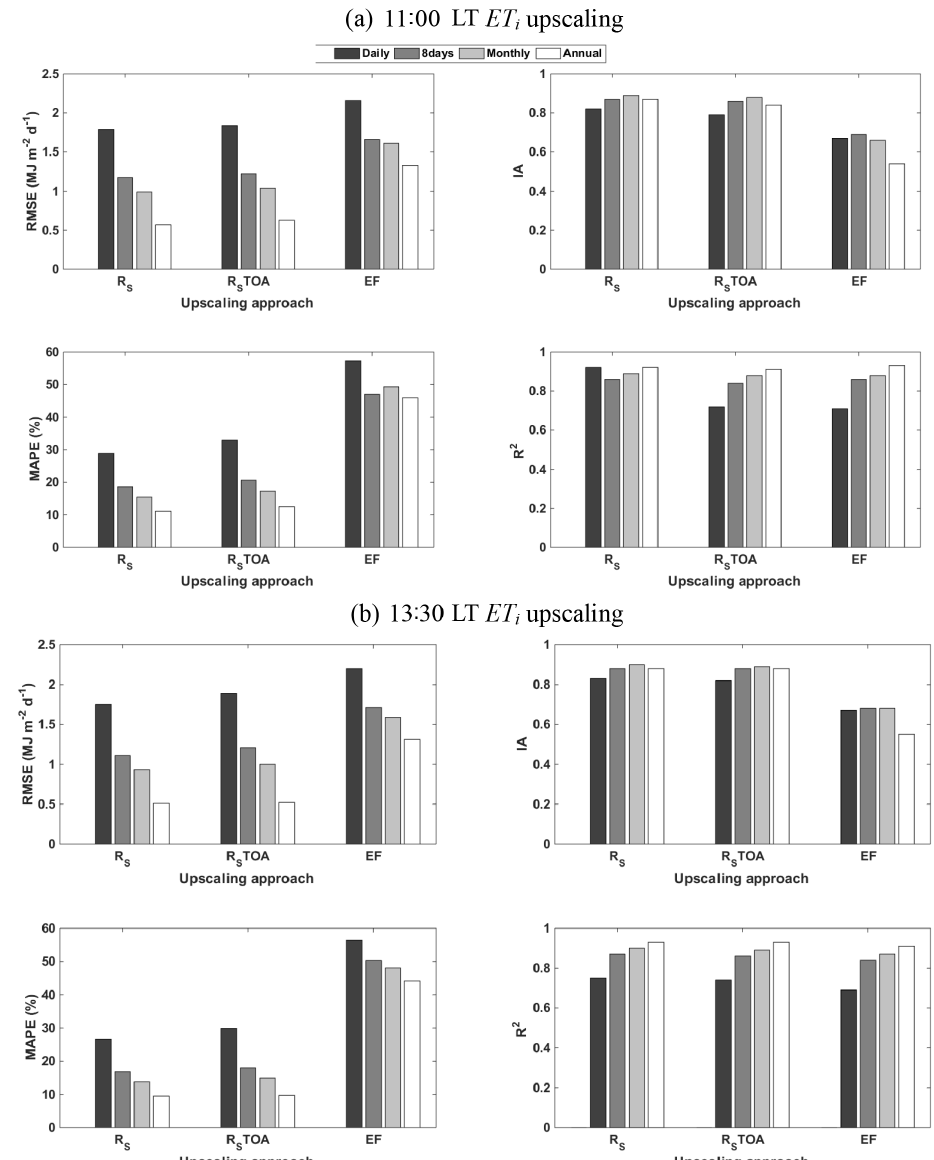
Figure 12. Statistical metrics of ET d_pred from three different ET i upscaling approaches [shortwave incoming radiation ( R S ) , exo- atmospheric shortwave radiation ( R S TOA) and evaporative fraction (EF)] at different temporal scales based on ET i measurements at (a) 11:00LT and (b) 13:30LT times of